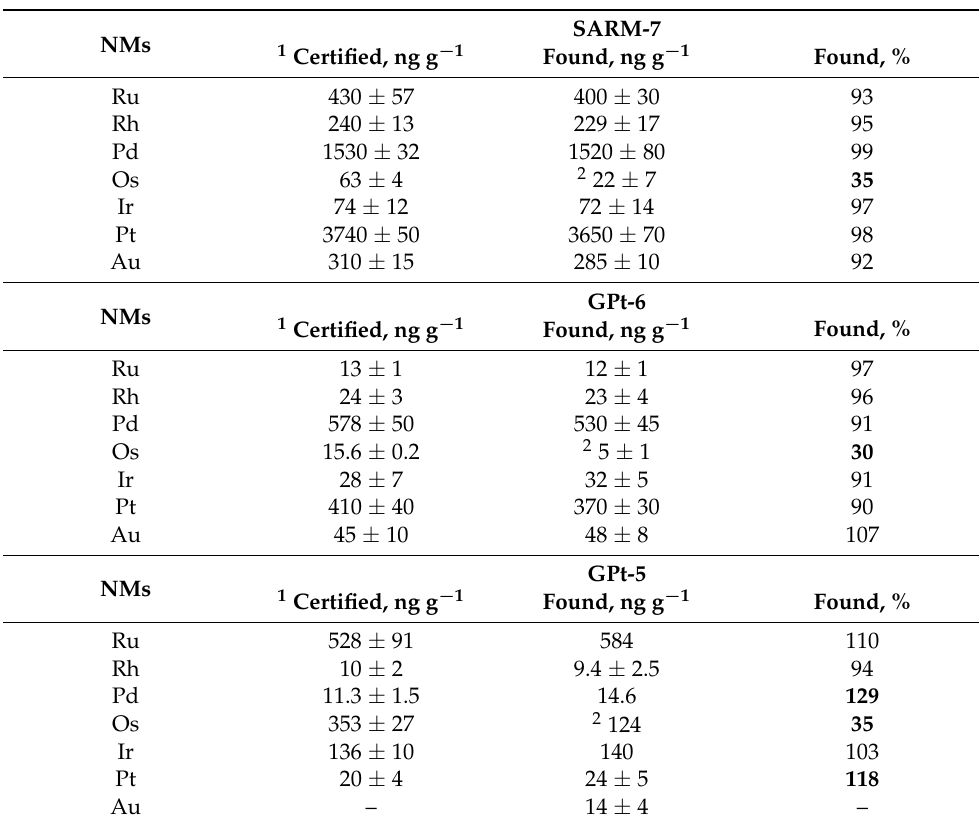
Figure 6. ( a ) Box plot of probability distribution of sorption degrees for 10 sequential big cycles of sorption–recovery. ( b ) Scheme of using the sorbent in small and big cycles. Table 8. Results of CRM (GPt-5, GPt-6, and SARM-7) analysis by ICP-MS (sorption conditions: C(HCl) = 1 M, sorbent: PVBC-VP; desorption conditions: 10 mL Tcy:Tu:HCl = 0.5 M:0.5 M:0.8 M; emphn = 10, p =